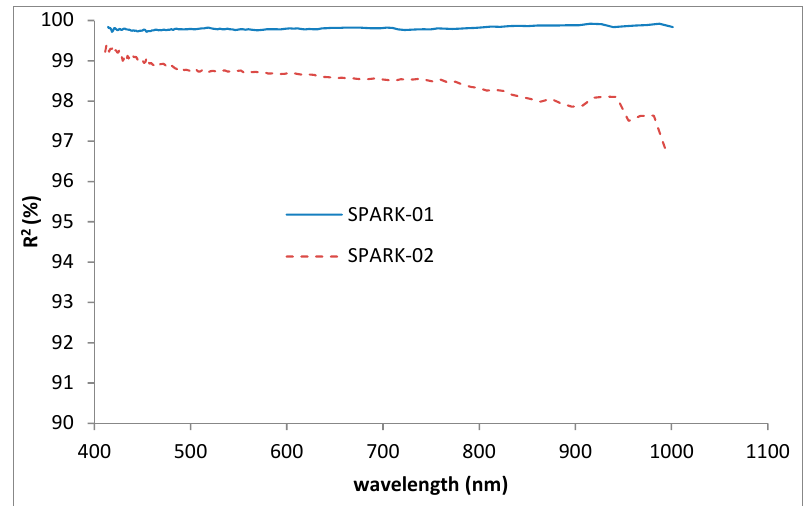
Figure 16. Goodness-of-fit statistics for diffuse-to-global irradiance ratio measurements according to Equation (8).